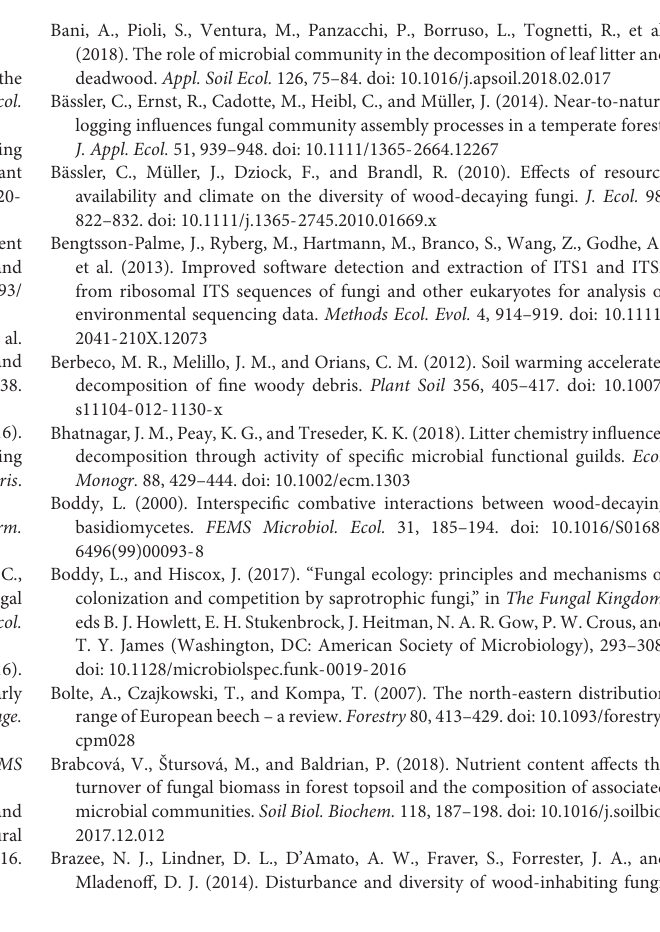
Small FWD: 0.5–1.5 cm in diameter, mid-size FWD: 1.6–5.0 cm in diameter, large FWD: 5.1–10.0 cm in diameter, parts with minimum lengths of 10 cm. Boxes indicate the lower and upper quartiles, and individual points represent separate 2 × 2 m sampling plots. Supplementary Figure 3 | Diversity of fungi during the decomposition of the FWD of beech and fir in a temperate natural forest expressed as OTU richness and Chao 1 estimates. Development of diversity estimated over time (left), overall differences not considering community development over time (right). Supplementary Figure 4 | Venn diagram representing the results of variation partitioning analyses on Hellinger-transformed OTU abundances. (A) Tree species and canopy cover calculated using all FWD samples, (B) canopy cover, time and deadwood chemism for beech FWD, C: canopy, time and deadwood chemism for fir FWD. Supplementary Figure 5 | Occurrence of fungal taxa during succession on beech and fir fine woody debris (FWD) in a montane forest according to FWD type and microclimatic conditions. Correlations between succession time (in years) of each fungal taxon present on mixed beech and fir FWD ( A , P < 0.0001), detected under open and closed canopies in beech ( B , P < 0.0001) or fir ( C , P < 0.0001) fine woody debris. All taxa with abundances above 0.5% in three or more samples and above 1% in at least one sample were